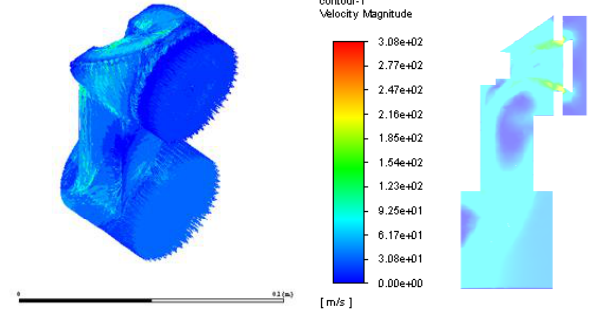
Fig. 12. The flow velocity of the fluid in the EGR valve covered inside by the CD layers